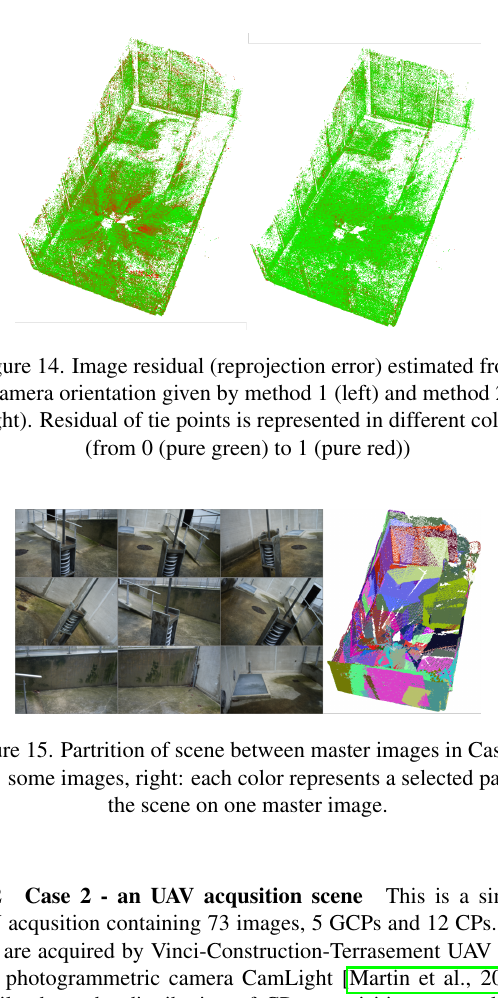
Figure 12. The terrestrial acquisition (Case 1). From the left: Distribution of GCPs (green) & CPs (red), acquisition protocal, initial mesh (from result of method 1) generated by MicMac.